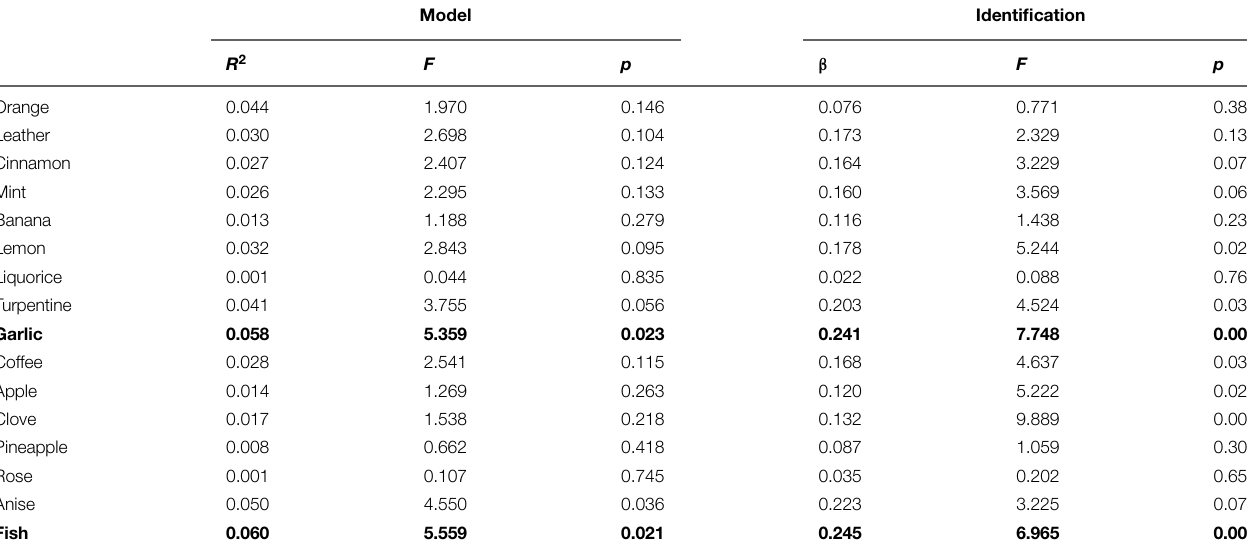
TABLE 2 | Categorical regression (CATREG) analysis for predicting odor pleasantness from identification (correct/incorrect) for the individual